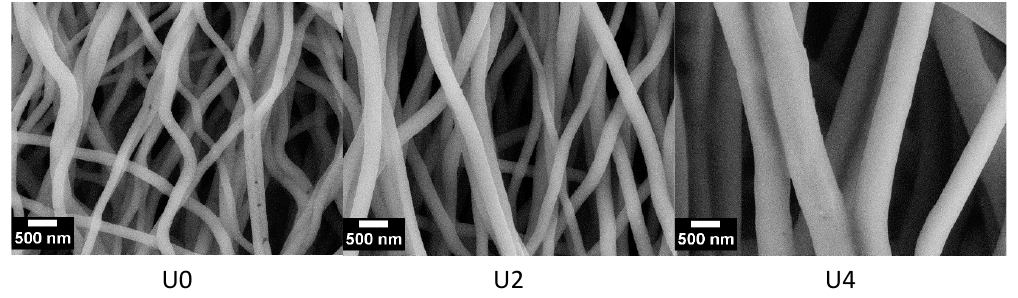
Figure 5. SEM images of the CFs carbonised at 850 ◦ C containing 0%, 25% and 50% CTP. Average diameter (Mean ± SD) for the carbonised samples U0, U2 and U4 was 0.25 ± 0.06, 0.28 ± 0.07 and 0.57 ± 0.15